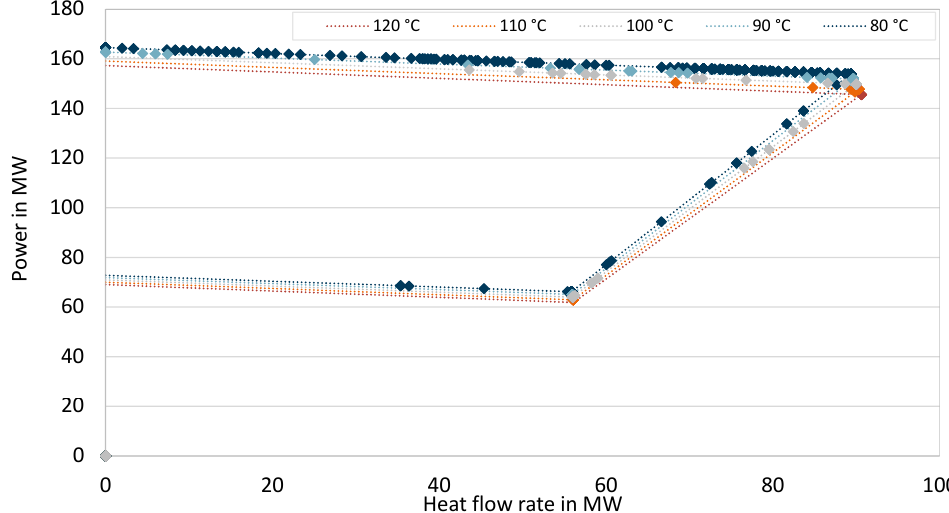
Figure 4. Validation of the resulting extraction steam turbine dispatch (diamond symbols) with the pre-calculated operational ranges in the business-as-usual (BAU) high scenario.